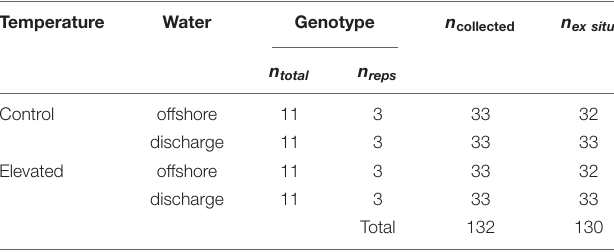
TABLE 2 | Sampling information for temperature and water treatment factors in the ex situ